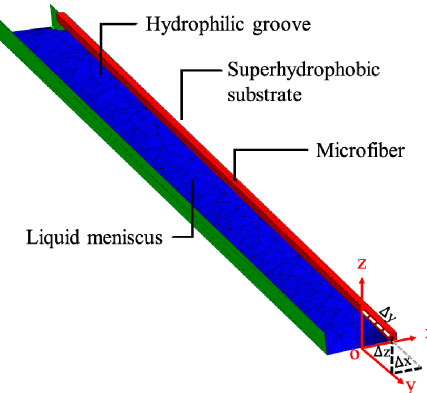
Figure 4. Surface Evolver model of the alignment of microfiber on a hydrophilic–superhydrophobic groove. The model includes three key elements: microfiber, hydrophilic–superhydrophobic groove, liquid meniscus.